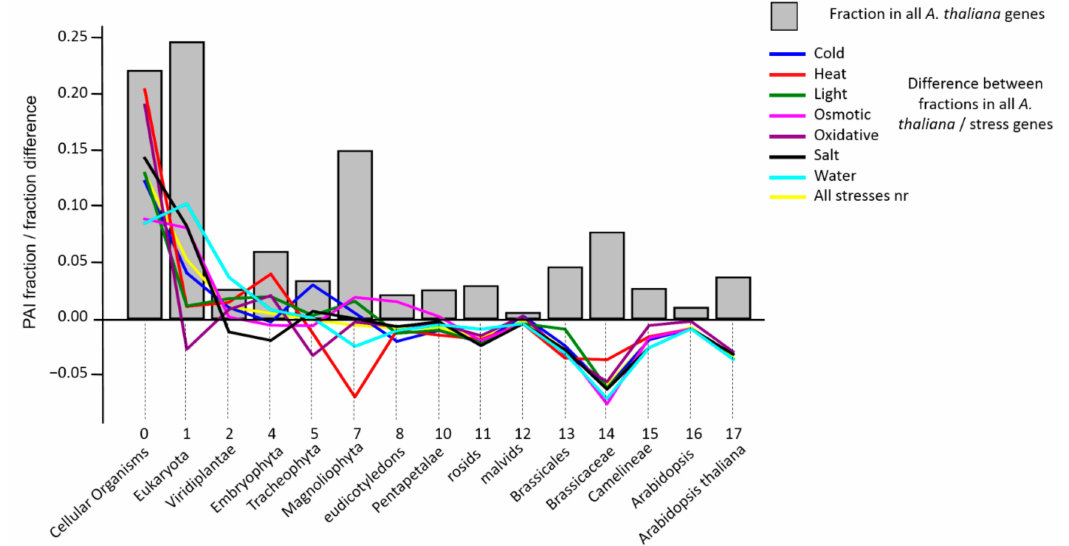
Figure 2. The distribution of frequencies of A. thaliana protein-coding genes (y-axis) by PAI (X-axis) is shown as grey bars. Solid lines indicate the values of the di ff erence between the frequencies of occurrence of PAI values in stress dataset and all A. thaliana genes (dfPAI i ). Correspondence of the line color and stress type is shown in the box in the upper right